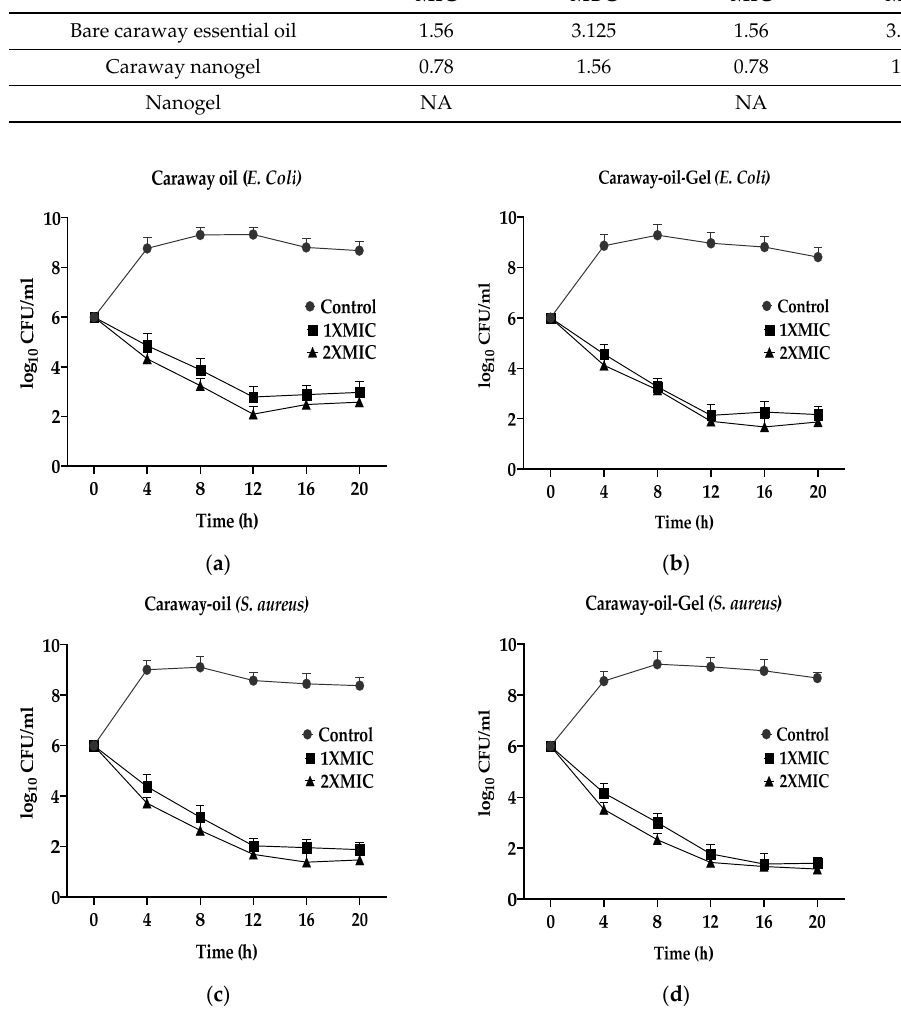
Table 2. Comparative MIC determination of the different compounds against E-coli and S. aureus . Sample